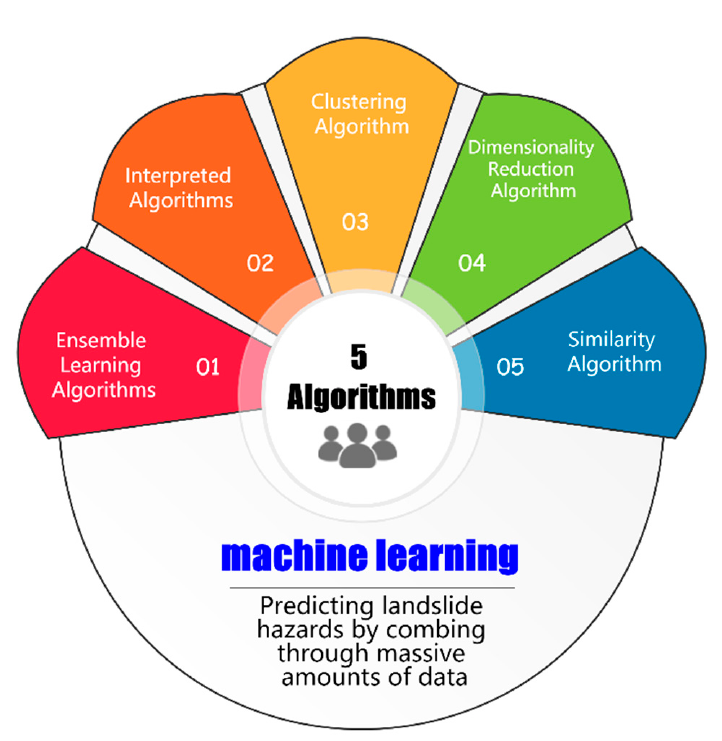
Figure 18. 5 Algorithms of machine learning.